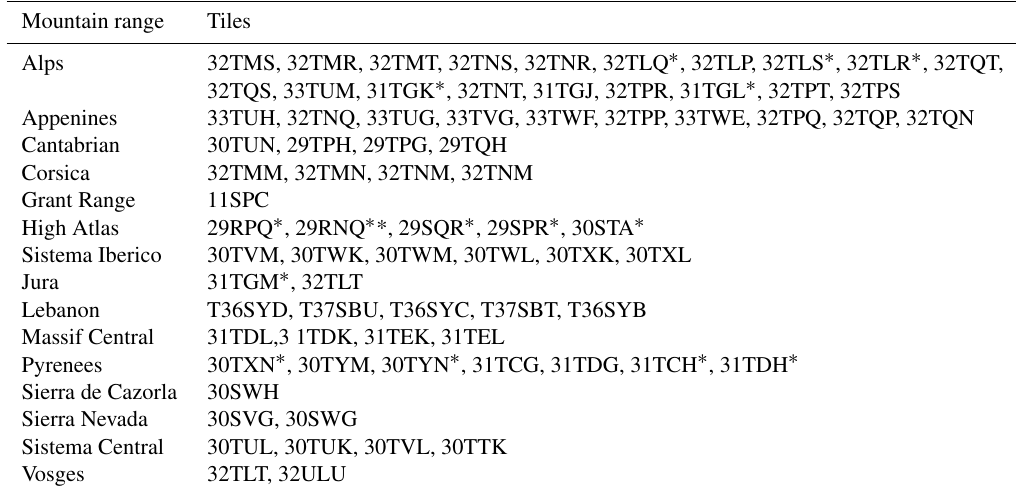
Table 3. Non-exhaustive list of mountain ranges covered by the Theia Snow collection and corresponding tiles. The tiles marked with an asterisk were made available before the start of the operational production (see Sect. 3).